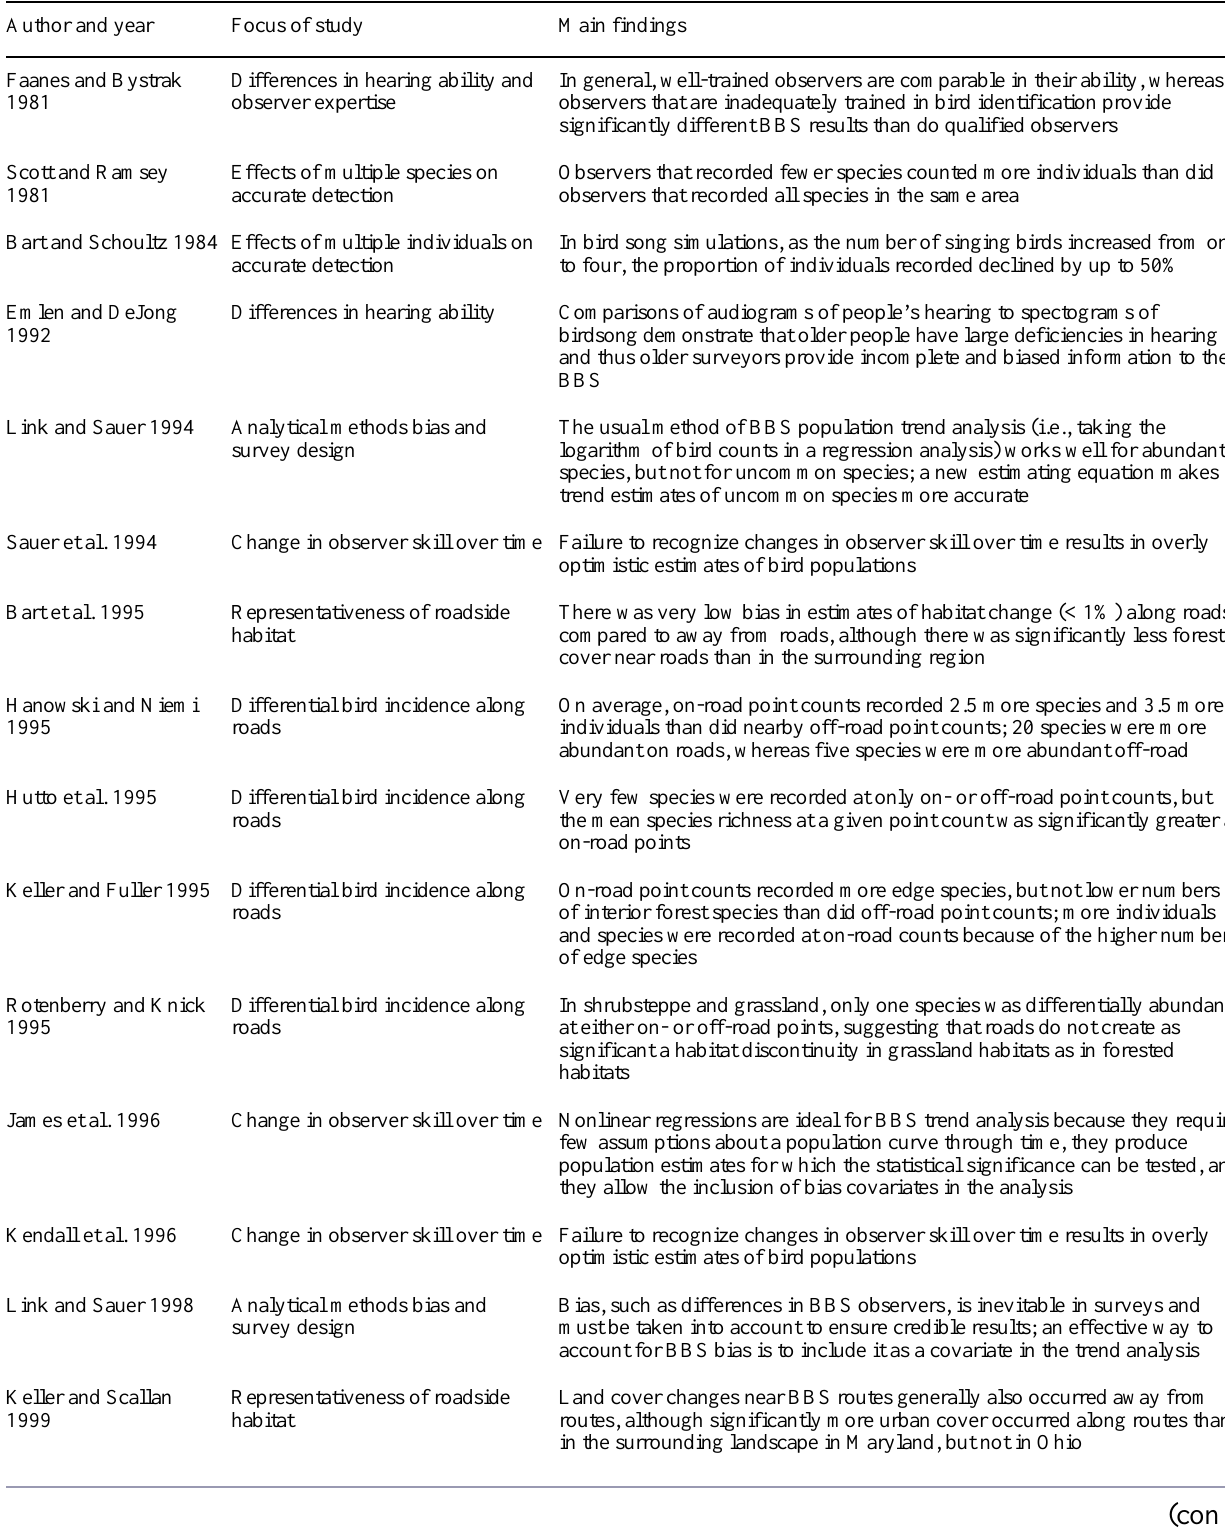
Table 1. Summary of the main findings of previous studies of bias in the North American Breeding Bird Survey